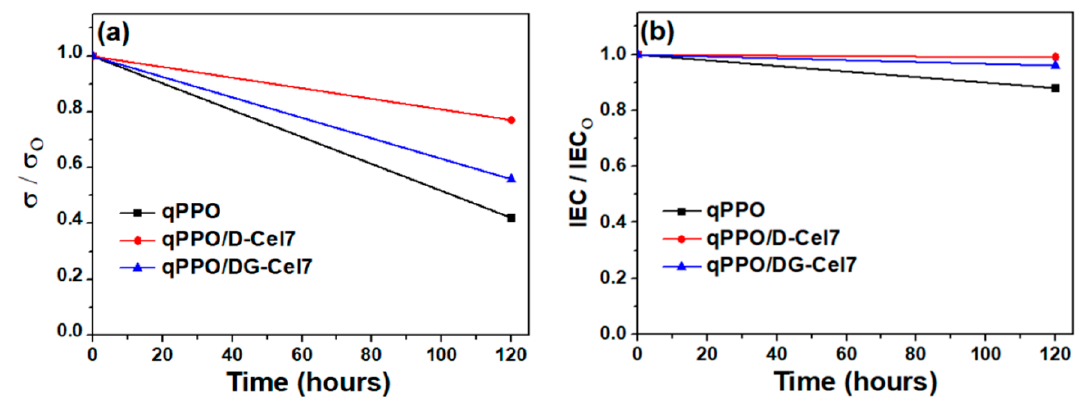
Figure 6. Alkaline stability of different anion exchange membranes (AEMs) in terms of the variations in ( a ) ionic conductivity and ( b ) ion exchange capacity (IEC) when treated with KOH solution (1 mol L − 1 ) at 60 °C.